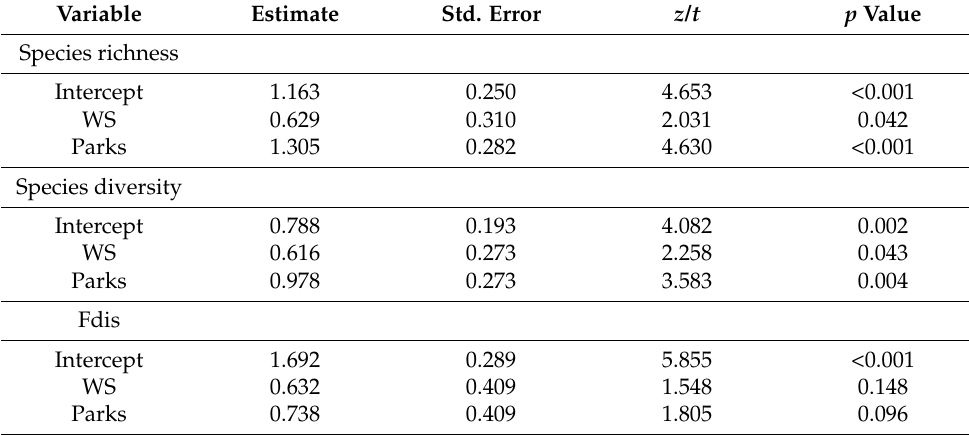
Table 1. Generalized linear model results showing differences in species richness, Shannon–Wiener index (H’), and functional dispersion (FDis) between habitat types. Habitat types: non-wooded streets (Intercept), wooded streets (WS), and parks; z/t indicates z or t